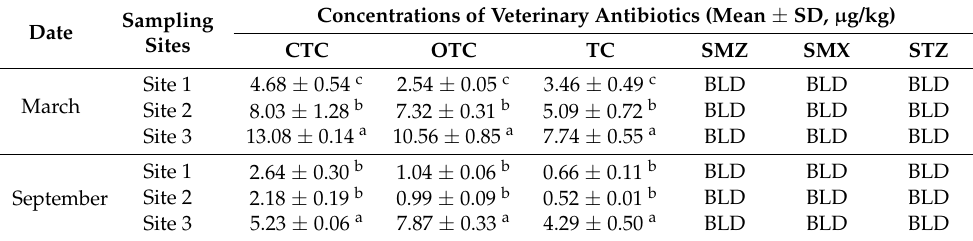
Table 5. Concentrations of veterinary antibiotics in